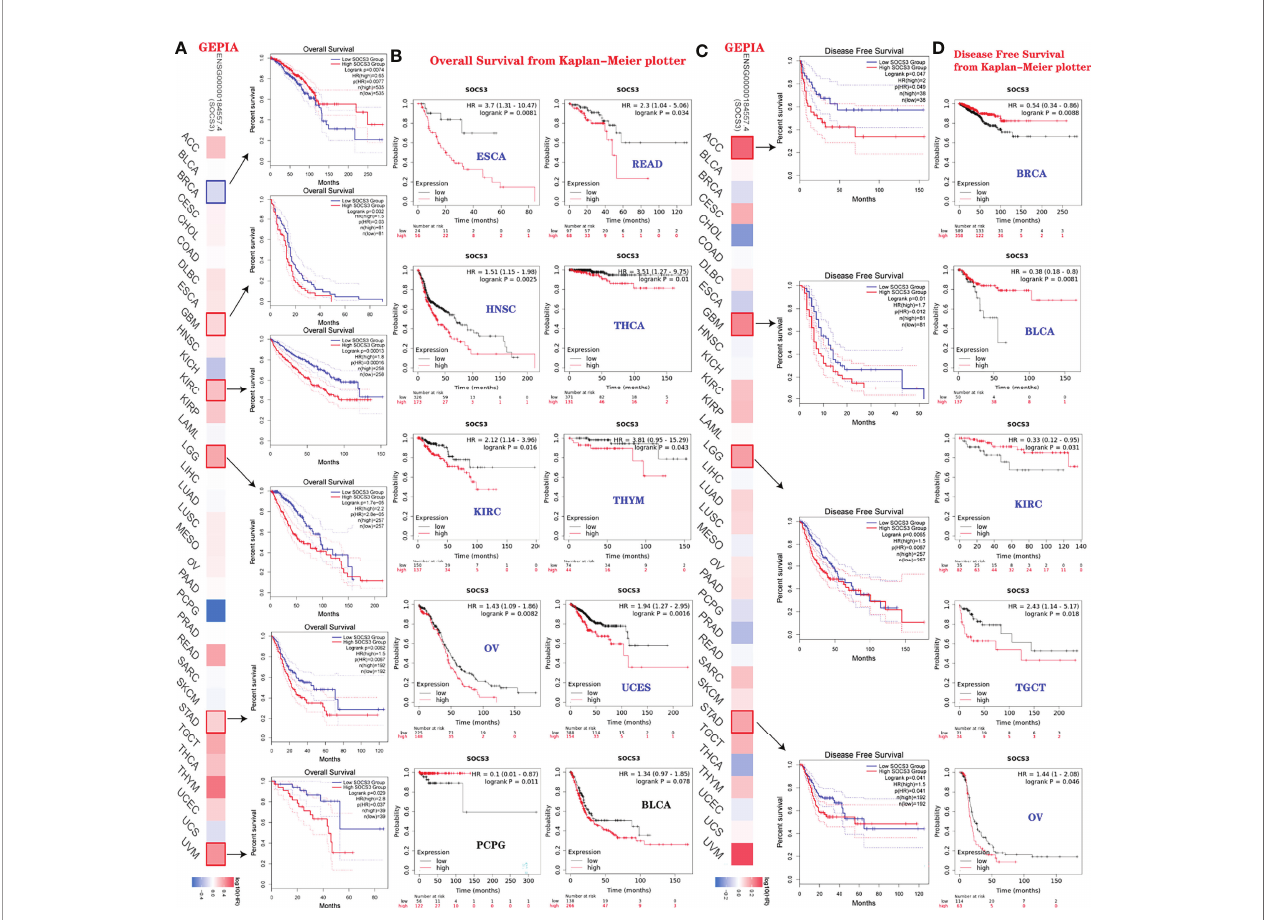
FIGURE 6 | Relevance between SOCS3 expression status and survival prognosis of various tumors in TCGA. (A, C) Analysis of the relationship between overall survival, disease-free survival, and SOCS3 expression levels in different cancers via GEPIA2 website. (B, D) Same analysis using Kaplan – Meier database.